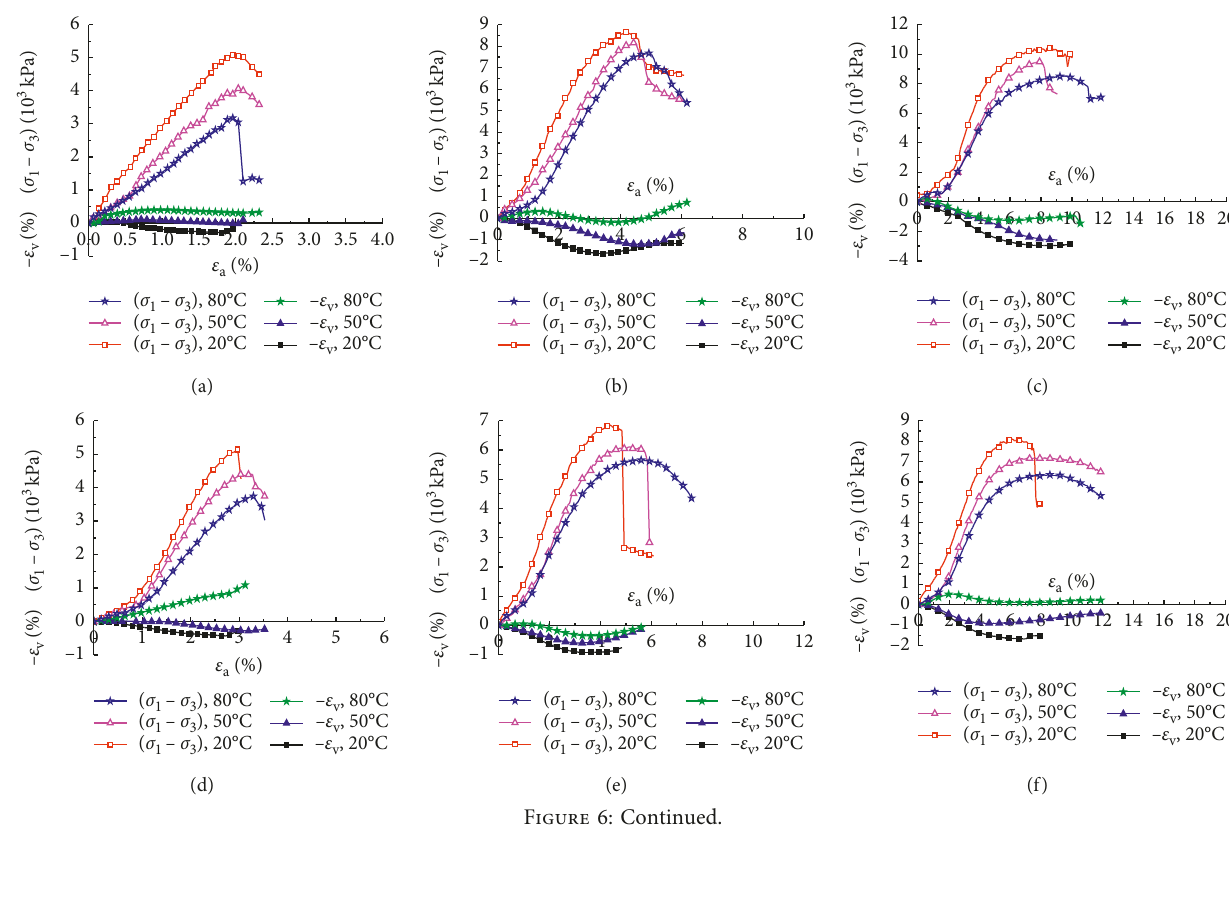
) ∼ ε − σ and ε ∼ ε of the samples under the dry density of 1.6 g/cm 3 with different water contents, 1 3 a v a � 1.6 g/cm 3 , w � 5%, σ � 0kPa. (b) ρ 3 d � 0kPa. (e) ρ � 1.6 g/cm 3 , w � 15%, σ 3 d � 0kPa. (h) ρ � 1.6 g/cm 3 , w � 25%, σ 3 d